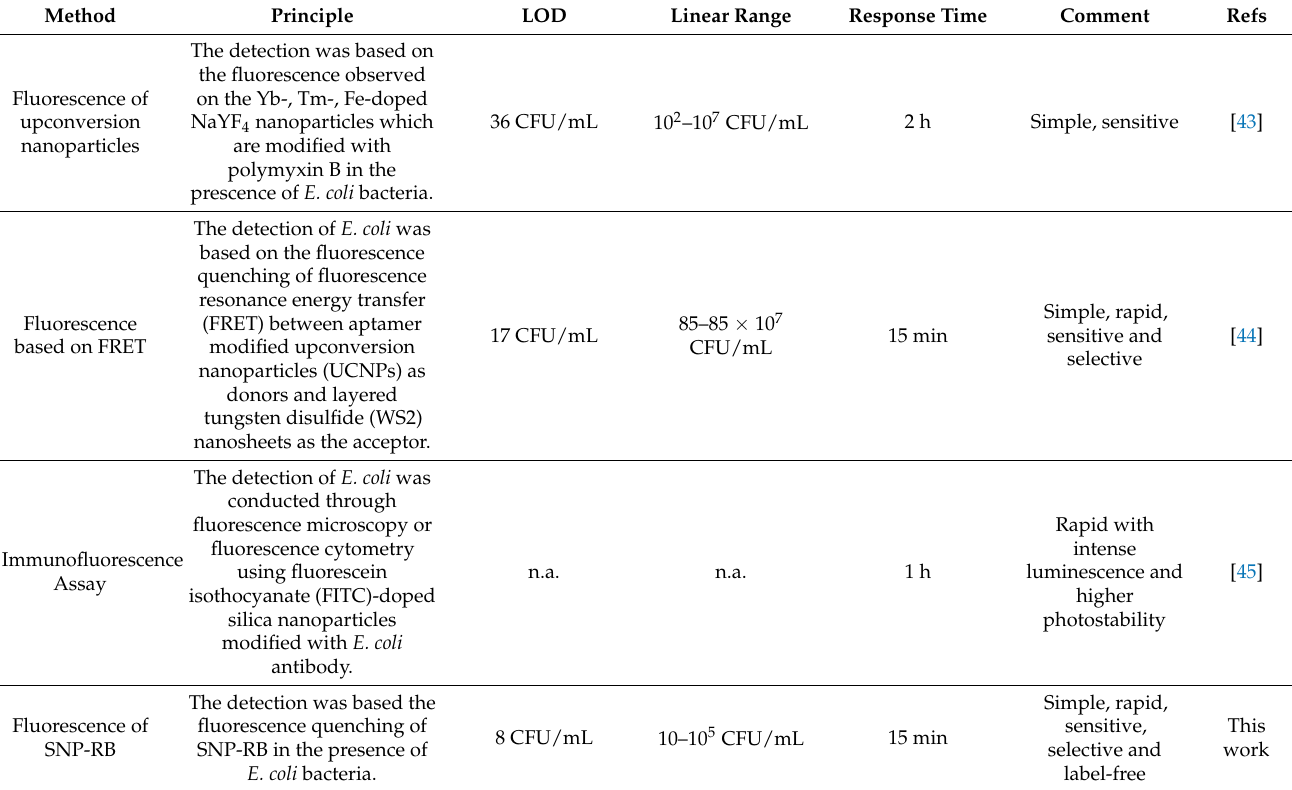
Table S1: Specific surface area, pore size, pore volume and nanoparticle size of SNP and SNP-RB samples at reaction temperature of 90 ◦ C and aging time of 18 h, Figure S2: Fluoroscence spectra of the nanoparticles samples compared to the fluorophore, Rhodamine-B in H 2 O at the same concentration of 5 × 10 − 5 M. Figure S3: Absorbance spectra of PBS (blue spectrum), SNP-RB (red spectrum) and SNP-RB in the presence of E. coli